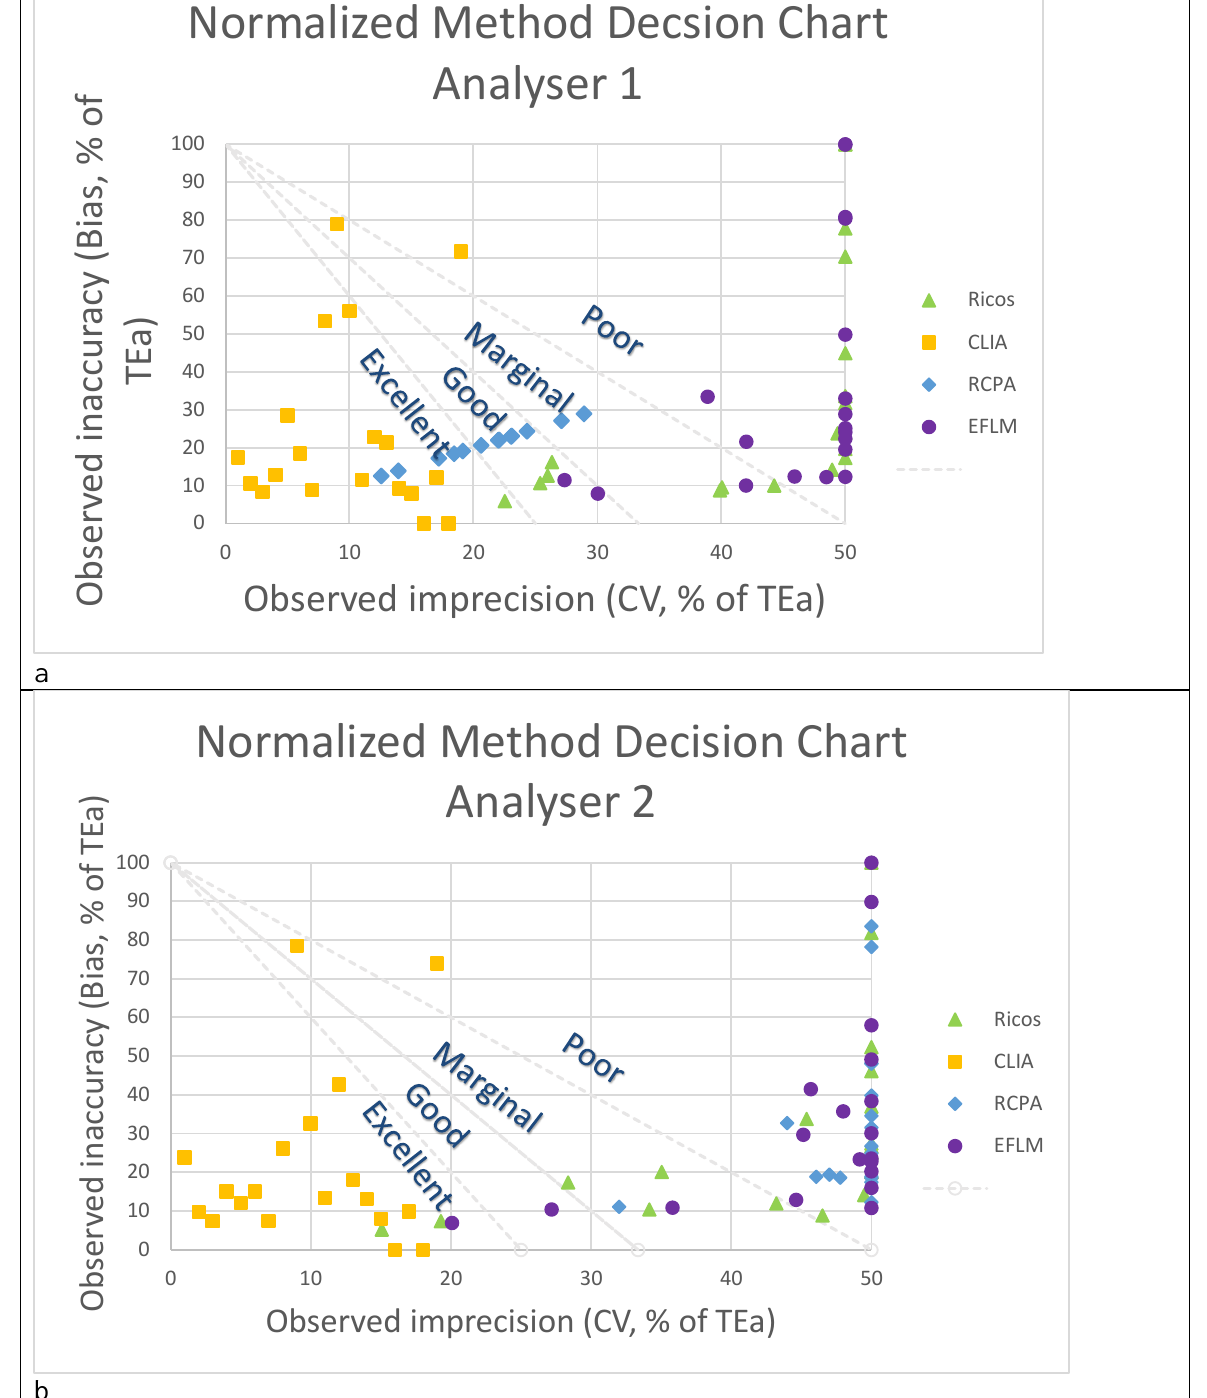
Supplementary Figure 2: Normalized Method Decision Chart for analytes based on different total allowable error guidelines, Johannesburg, South Africa, January 2017 – December 2017. (a) Analyser 1 (b) Analyser